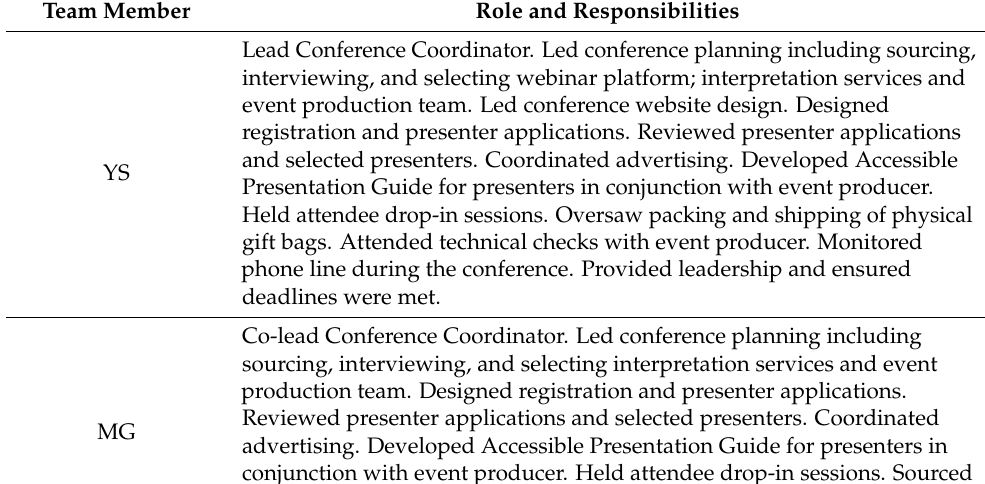
Table 4. Roles and responsibilities of research team